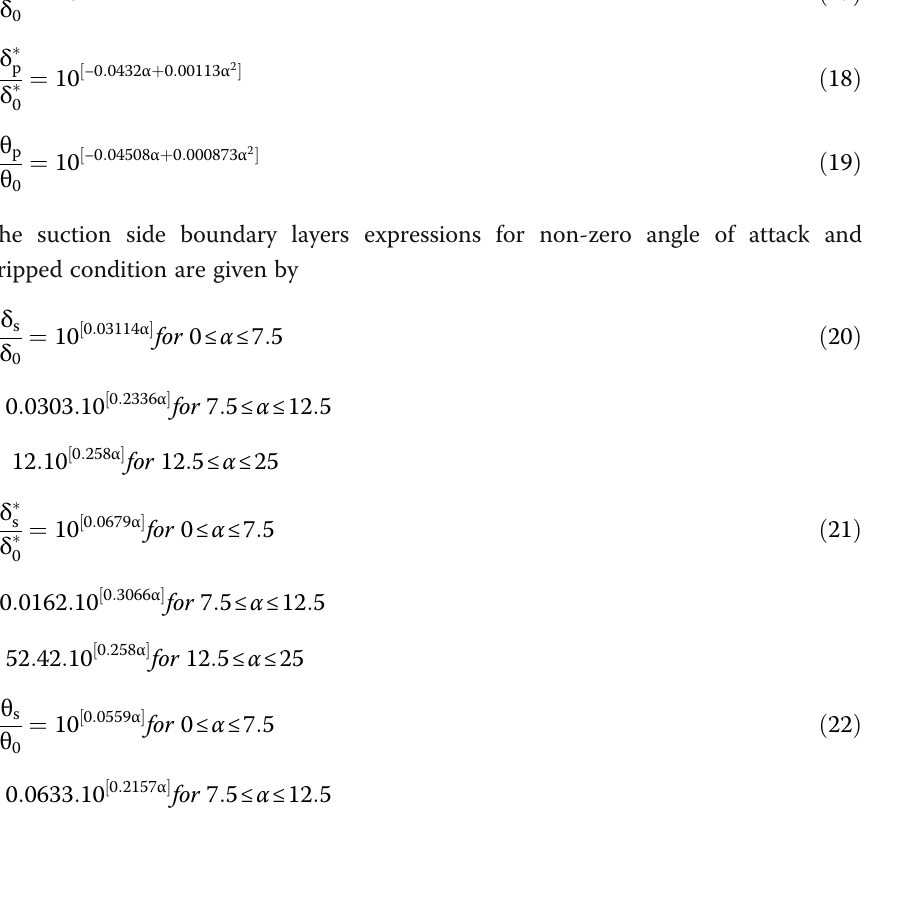
For non-zero angle of attack on aerofoil, the boundary layer thickness, displacement thickness and momentum thickness of the pressure side of aerofoil are same for tripped and untripped conditions and a function of Reynolds number.